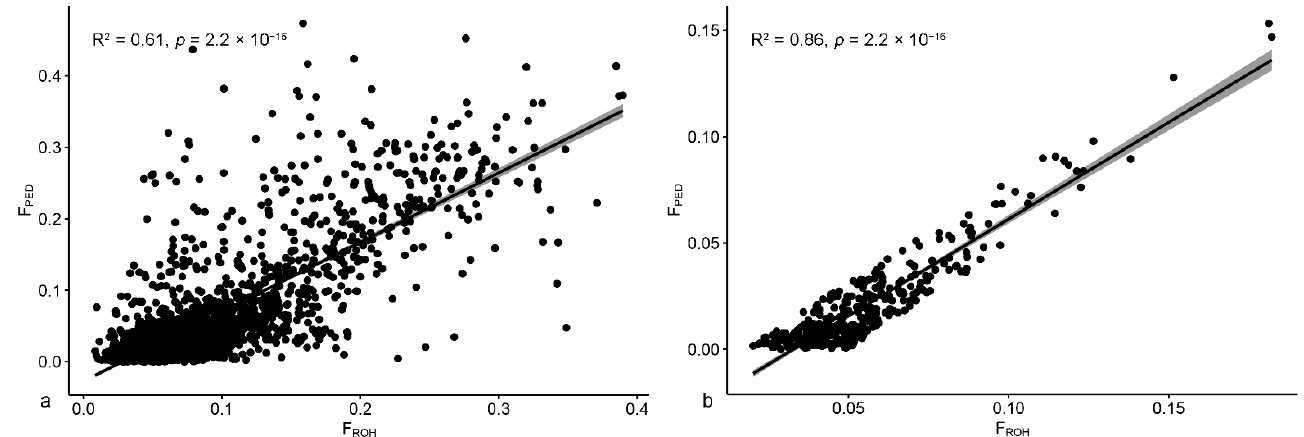
Figure 3. Linear regression models to estimate F PED from F ROH . ( a ) Linear regression model calcu- lated on all the animals with FullGen ≥ 4. ( b ) Refined model (removing animals falling below the 1st and above the 3rd quartile of the standardized residual distribution) for goats with FullGen ≥ 4.